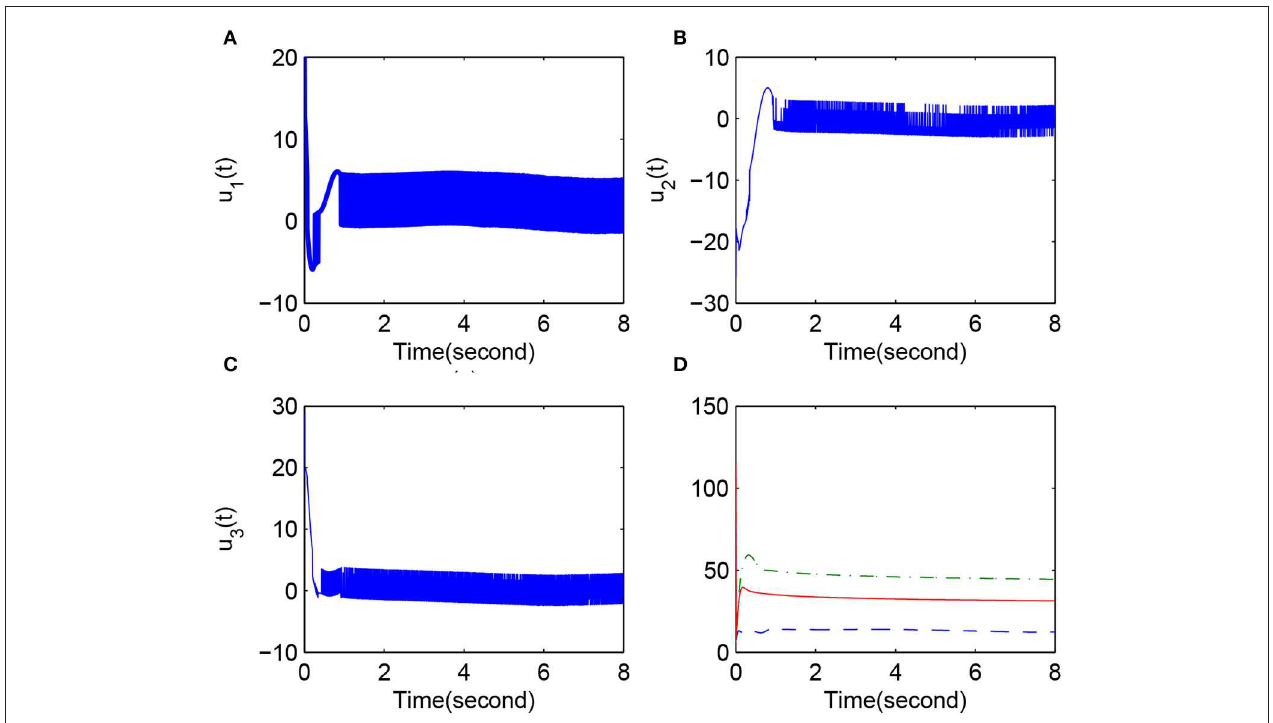
FIGURE 3 | Control variables and fuzzy logic system parameters of Case 3.